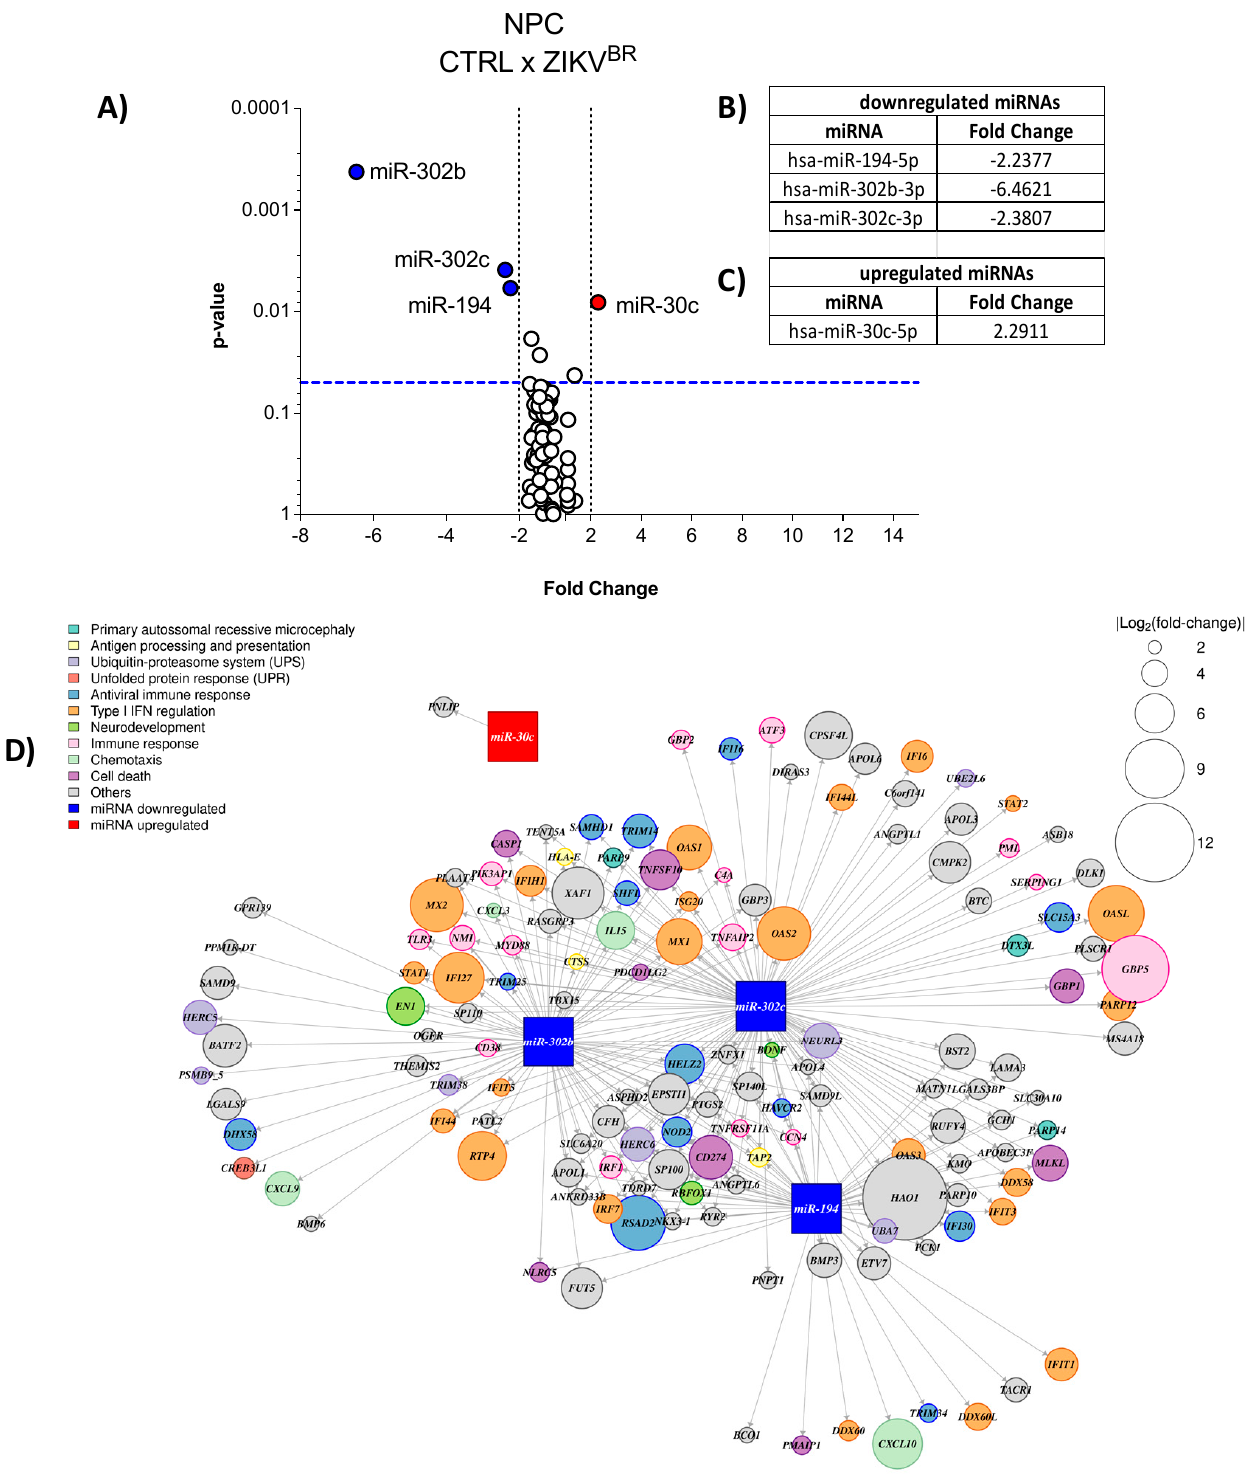
Figure 2. ZIKV modulates miRNA profile in human NPCs. ( A ) Human NPCs were infected or not with ZIKV (MOI = 1). After 48 h we evaluated the miRNA profile by qPCR array. Volcano Plot, white dots—unaltered; blue dots—downregulated; red dots—upregulated. Three independent experiments. Each plate represents a pool of samples (n = 3) from each independent experiment. ( B ) Table of downregulated miRNAs; ( C ) Table of upregulated miRNAs. ( D ) Interactome of modulated miRNAs and their predicted targets in hiNPCs from public